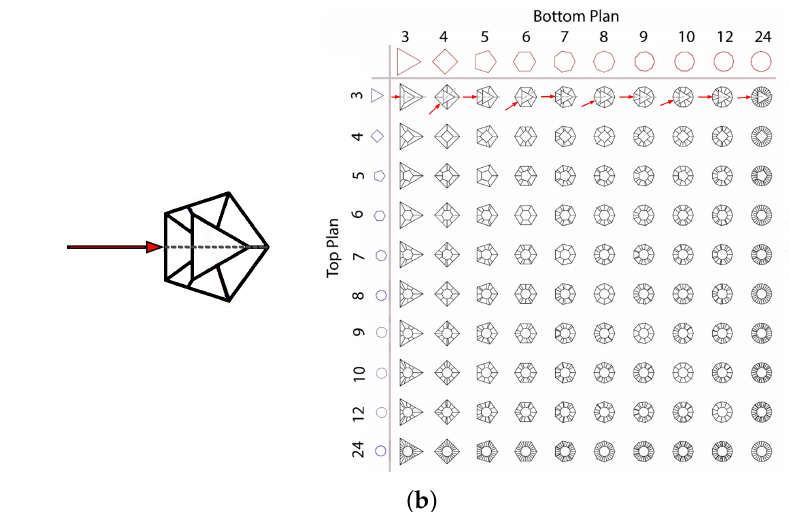
Figure 1. Generation of the 144 architectural models for the tall buildings considered in this work. ( a ): perspective. ( b ): plan view to get details of top and bottom floor plans, and direction of the applied seismic